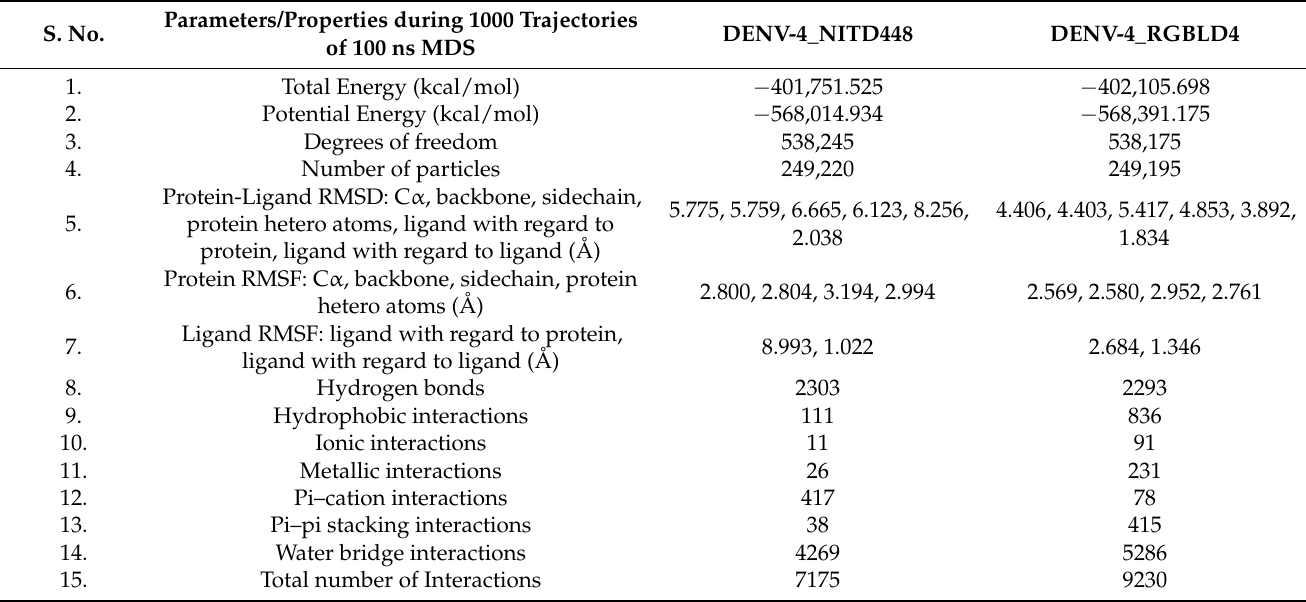
Table 9. Comparison of scores obtained in the molecular dynamic’s simulation parameters for DENV-4 reference molecule and novel analog